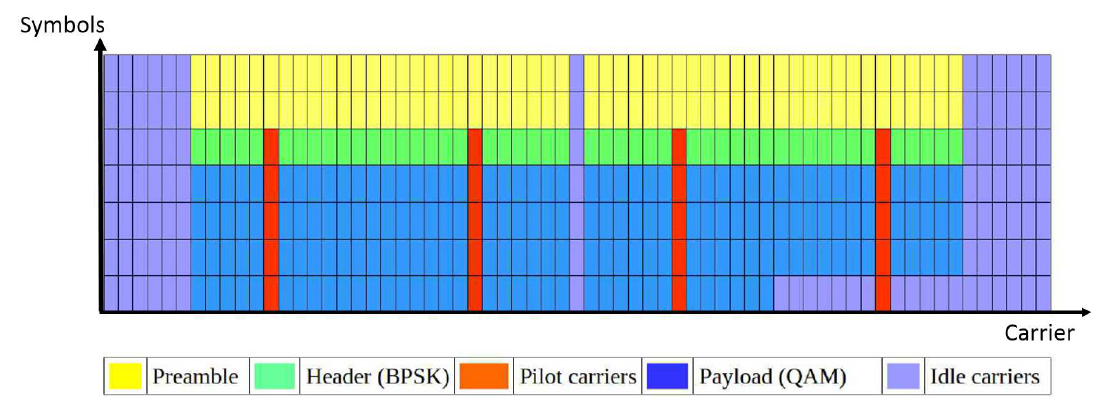
Figure 3. The packet structure used in the example OFDM transceiver in GNU